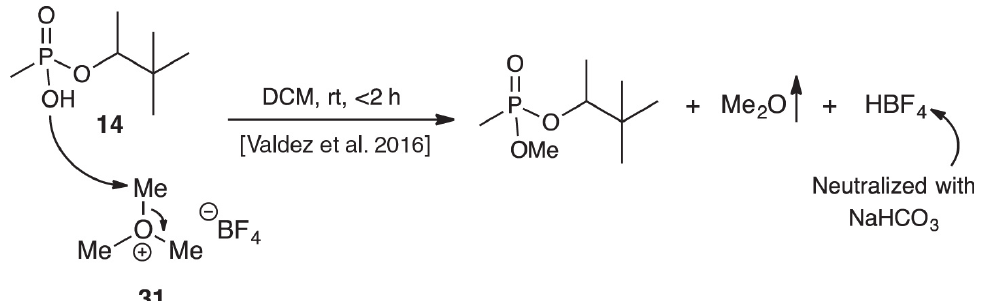
Figure 5: Proposed mechanism for the methylation of pinacolyl methylphosphonic acid ( 14 ) by TMO . BF ent derivatization yields a methyl ester that is now amenable for detection by GC-MS.